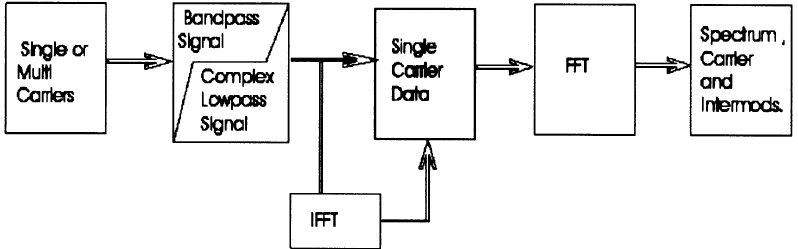
FIGURE 8 Block diagram of